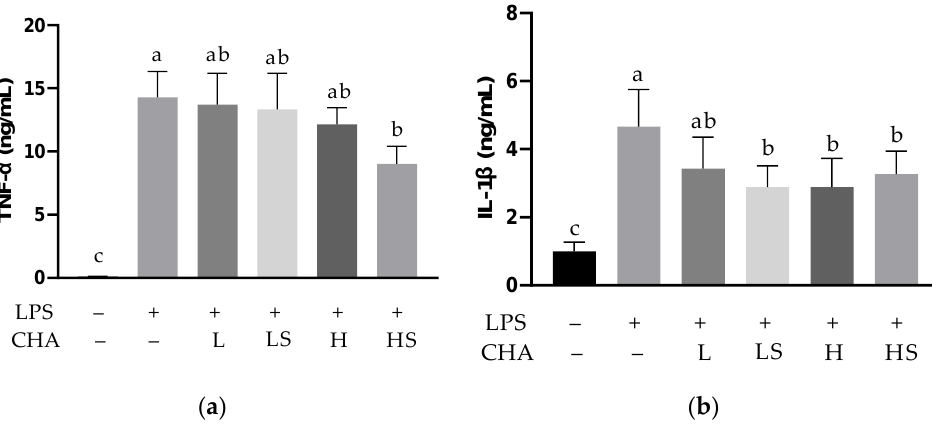
Figure 3. Effect of different delivery models on the secretion of TNF- α and IL - 1β. C ells were treated with LPS (100 ng/mL) and CHA for 24 h. ( a ) TNF- α concentration in the conditioned medium and ( b ) IL- 1β concentration in the conditioned medium were determined. Bars without a common letter indicate significant differences ( p < 0.05). CHA: chlorogenic acid; LPS: lipopolysaccharide; TNF: tu- mor necrosis factor; IL-interleukin; L: low dose administered via pipette; LS: low dose administered via syringe pump; H: high dose administered via pipette; HS: high dose administered via syringe pump.